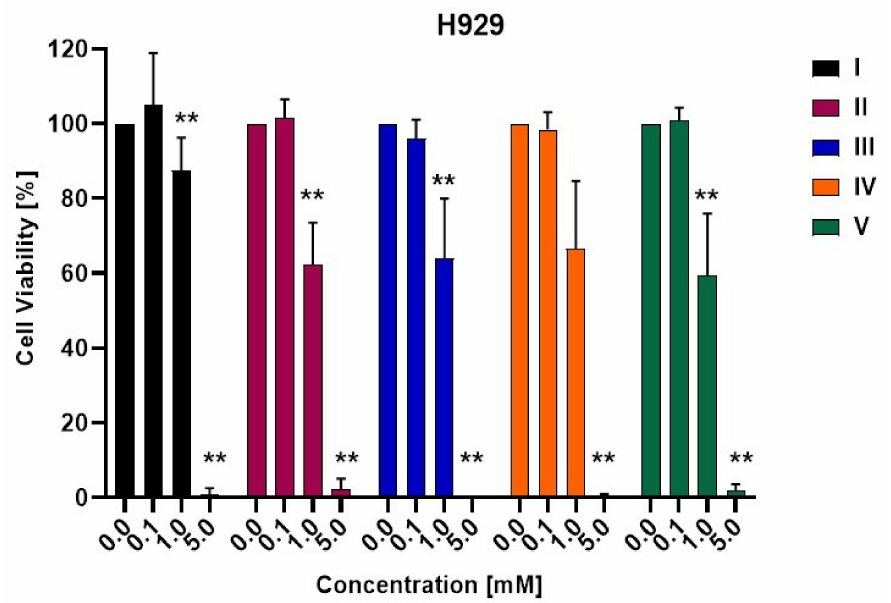
Figure 7. Compounds I – V demonstrates cytotoxicity in H929 starting from 1 mM. H929, a Multiple Myeloma cell line was treated with was treated for 48 h indicated concentrations of Compounds I – V . Cell survival was determined using the CellTiter-Glo ® Luminescent Cell Viability Assay (Promega). One-way ANOVA followed by Bonferroni post hoc test were used to assess significant differences between the treatment groups and the vehicle control. ** p <